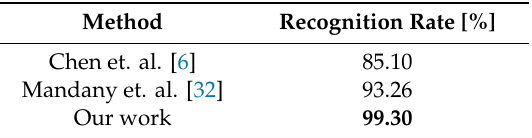
Table 5. Comparison of the recognition rates for the UTD-MHAD set and realizations 1 and 2 in the training set and 3, 4 in the test set.